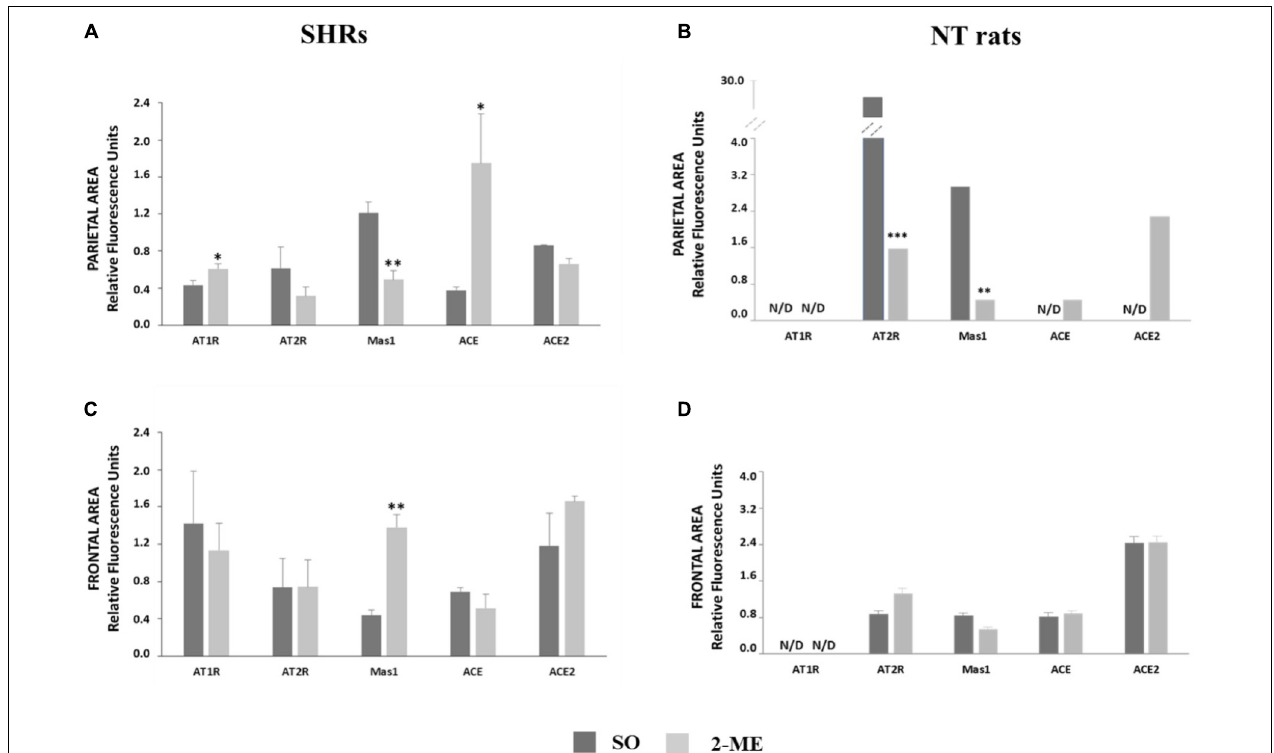
FIGURE 3 | Representation of gene expression of AT1R, AT2R Mas1, ACE and ACE2 in SHRs ( N = 5) or NT rats ( N = 6) undergoing a double ME and their comparison with SO in parietal ( A , SHRs and B , NT rats) and frontal ( C , SHRs and D , NT rats) areas. Data are expressed as mean ± SEM. ∗ p < 0,05; ∗∗ p < 0.01; ∗∗∗ p < 0,0001 vs.